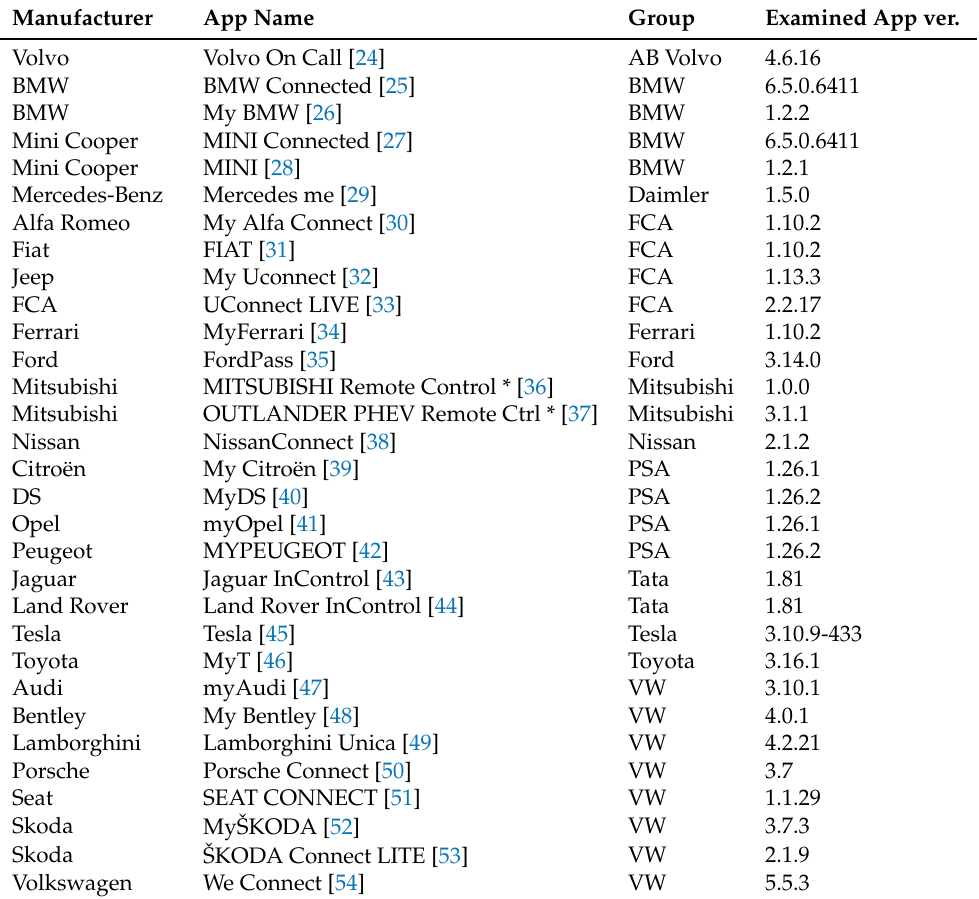
Table 1. Official car management apps found in Google Play Store. * In the following, they are referred to as MITSUBISHI RC and OUTLANDER PHEV RC,